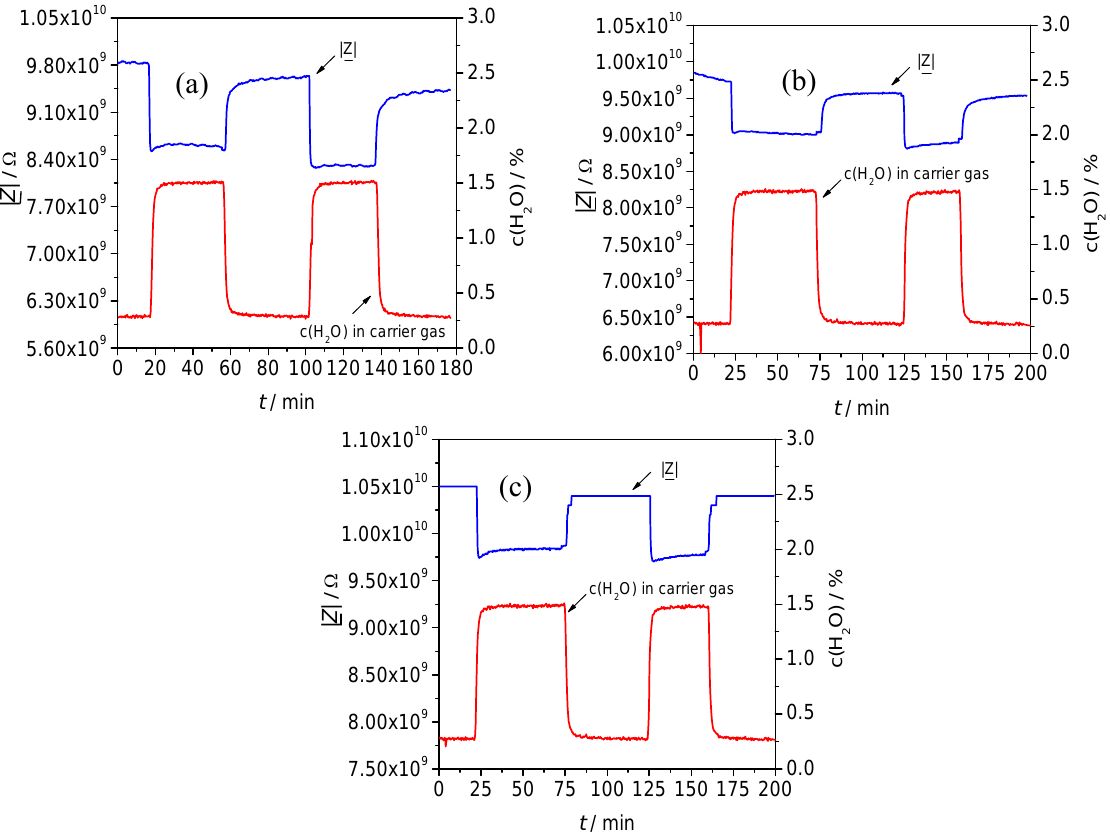
to 1.5 vol% H O consecutively. 2 2 O; S = 11.1 %/vol%H O (b) Fe-BTC ld (Li- 2 2 2